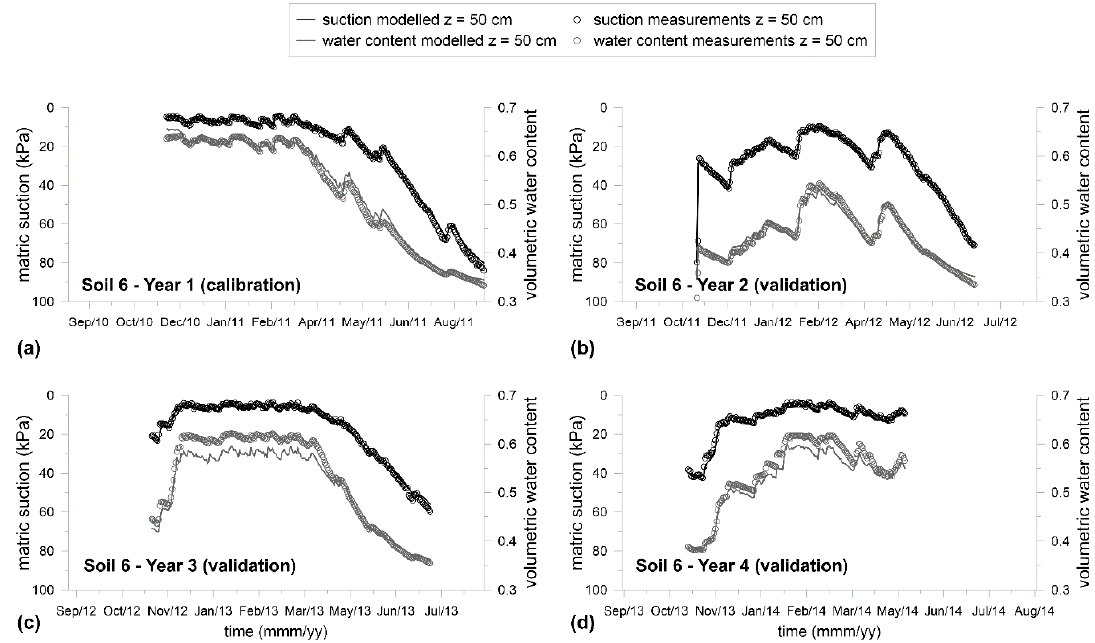
Figure 6. Results for soil 6 through monitoring by the lysimeter (medium scale). Experimental measurements of matric suction and volumetric water content at 50 cm (symbols) compared to the calculated values (continuous lines) by the model over time for soil 6 over the ( a ) first, ( b ) second, ( c ) third, and ( d ) fourth hydrological year of physical model monitoring. The first year was used for calibration, and the others were used for validation.